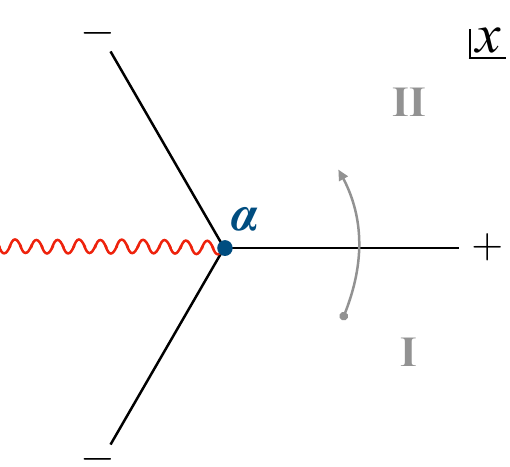
Figure 3 . The Airy-type Stokes graph emerging from a turning point a . The sign +( − ) labeling p each lines means increasing (decreasing) Re 1 Q ( x ) dx as going out from the turning point along ~ the line. The wavy line denotes a branch cut. By crossing the curve labeled by + in anti-clockwise manner, the wave funtions in the I and II domains are related to each other as ψ a, I = M + ψ a, II